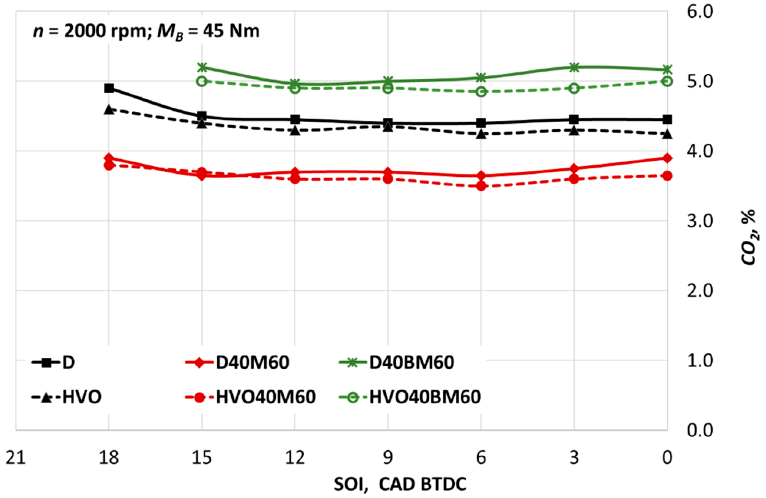
Figure 5. Change of CO 2 volumetric fraction depending on fuel composition and SOI.